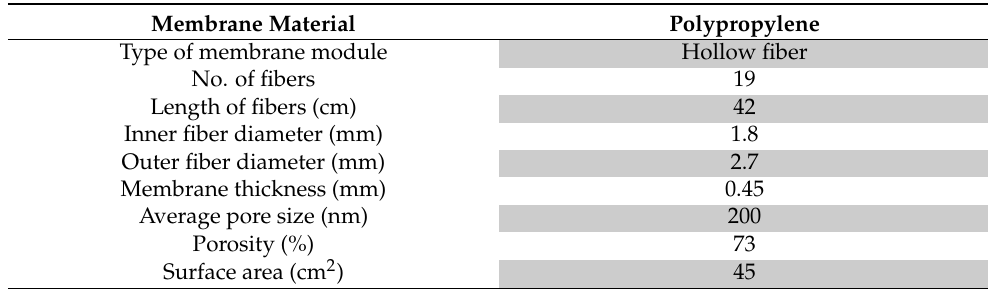
Table 1. Description of the applied membrane and membrane